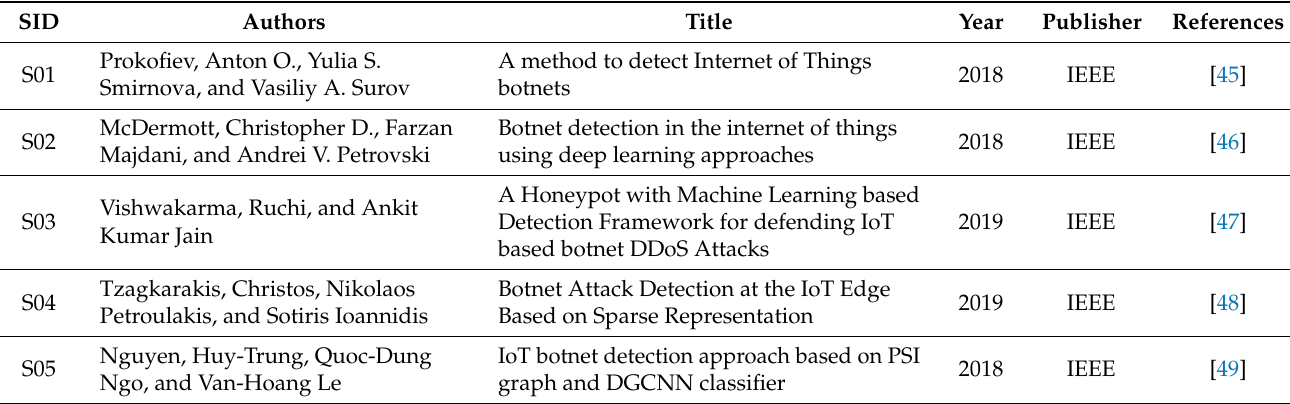
Figure 6. Number of studies distributed through search sources. Table 6. The studies selected after